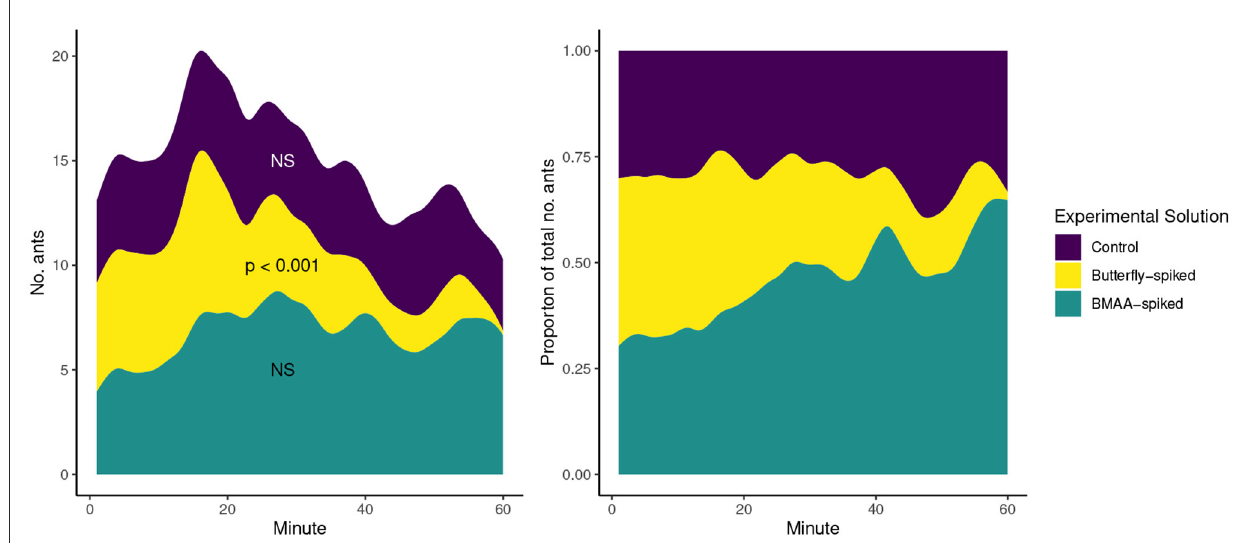
FIGURE5 The number of ants (left) and the proportion of total ants (right) feeding on three experimental solutions for 60 min. At the beginning of the experiment, the numbers of ants feeding on each solution were roughy equal, whereas the number of ants feeding on the butterfly-spiked solution decreased significantly over the course of the trial